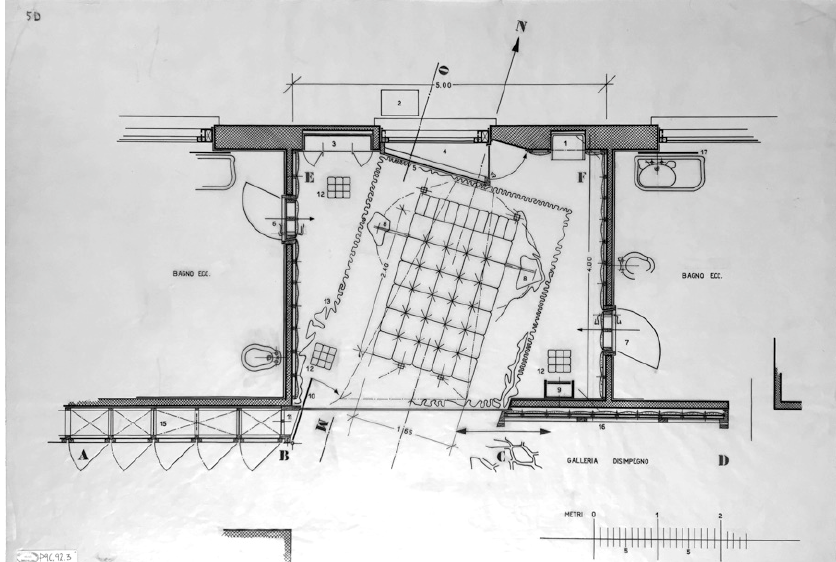
Figure 1. ACM P.9C.92.3: Plan of the bedroom for a farmhouse in the rice fields